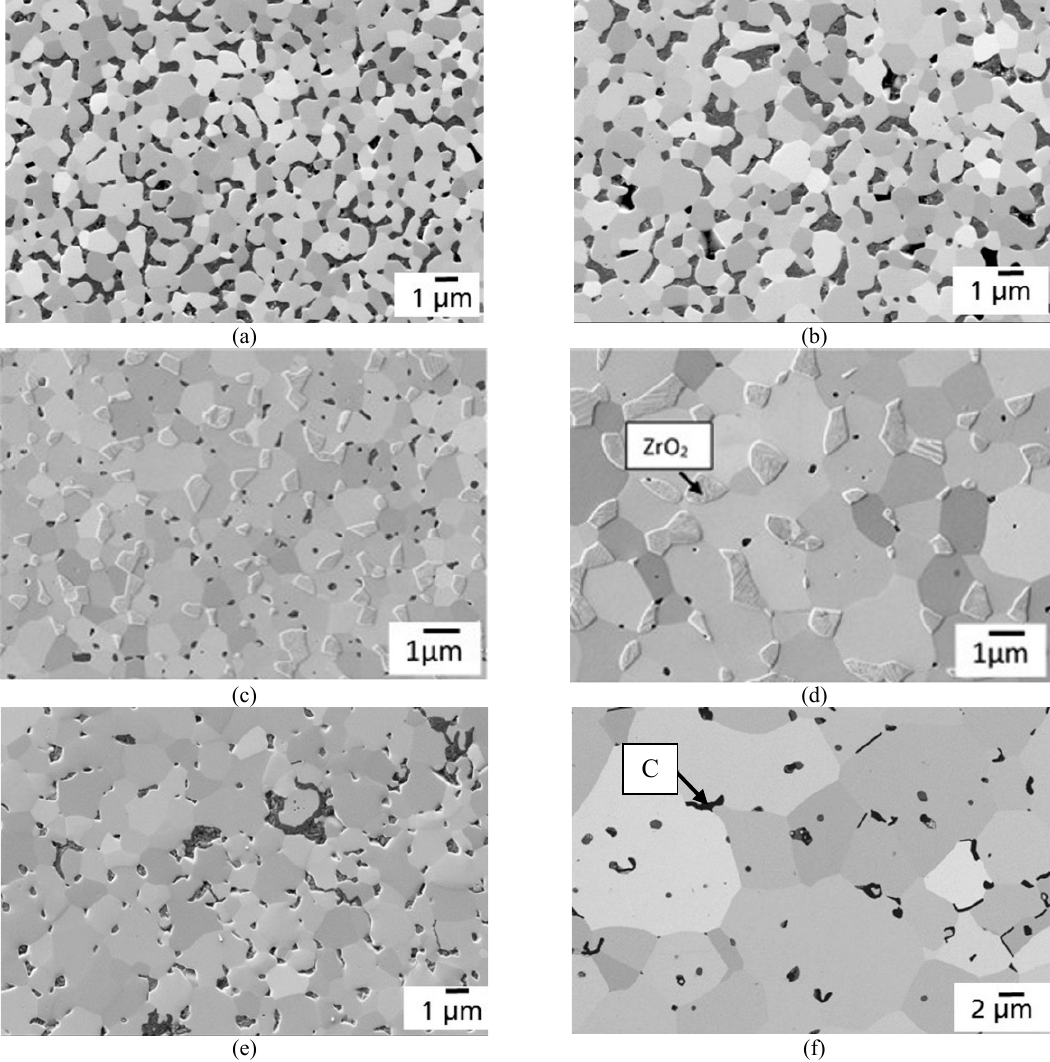
Fig. 7 (a) ZC 1-3.0, ZrC 1900 ℃ ; (b) ZC 1-3.0, ZrC 2000 ℃ ; (c) ZC 1-2.6, ZrC 1900 ℃ ; (d) ZC 1-2.6, 2000 ℃ ; (e) ZC 1-3.2, ZrC 1900 ℃ ; (f) ZC 1-3.2, ZrC 2000 ℃ .